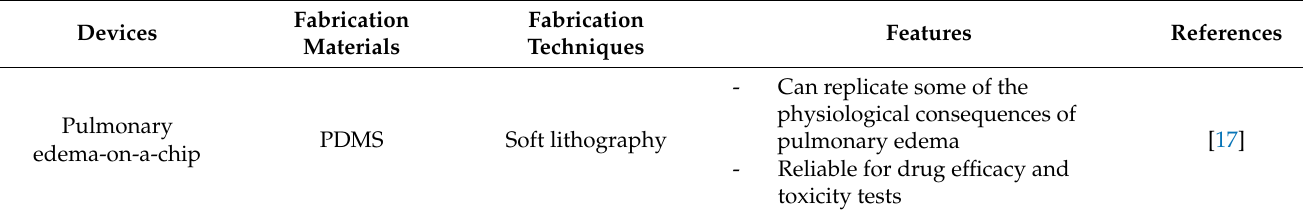
Figure 2. Example of processes involved in developing OOAC devices. Figure generated using BioRender.com (accessed on 16 May 2022). Table 1. Lung-on-a-chip device fabrication